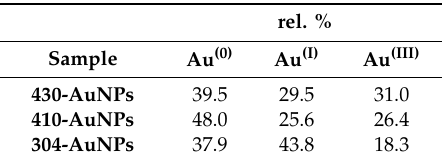
Table 3. Relative abundance of gold chemical states relevant to the gold colloids synthesized with AISI 430, 410 and